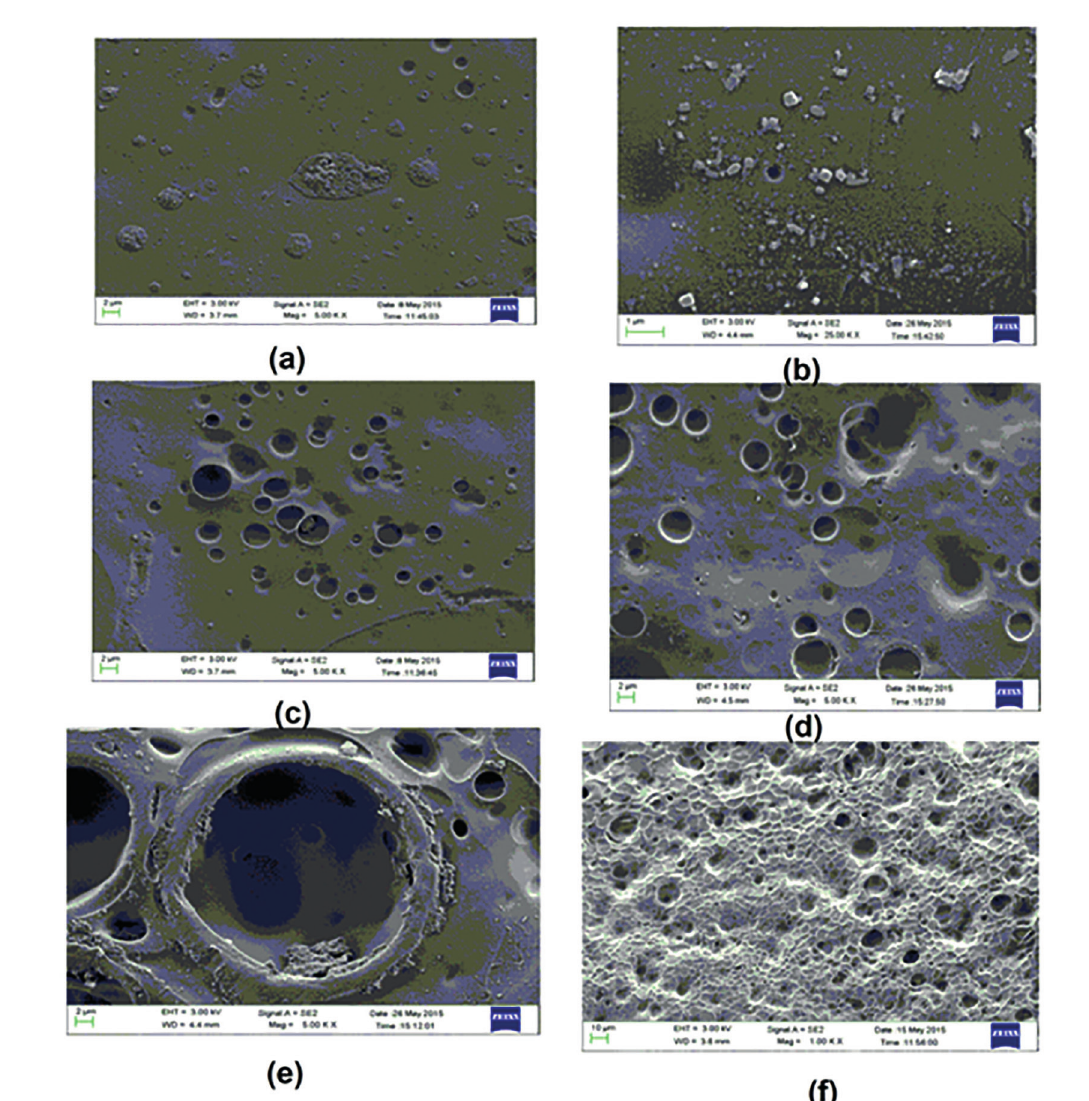
Figure 9: SEM photographs of pure and Mn 2+ doped PVC polymer films (a) pure (b) 1mol% (c) 2 mol% (d) 3 mol% (e) 4 mol% (f) 5